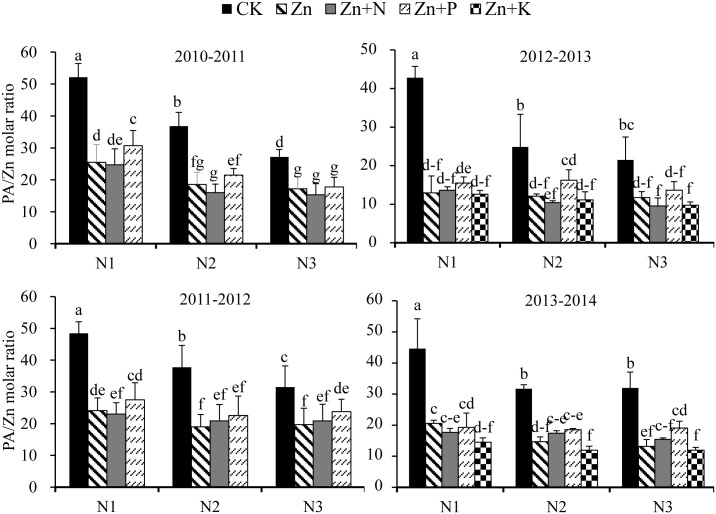
Grain PA/Zn molar ratio of winter wheat as influenced by soil N fertilizer rate (0 [N1], 120 [N2] or 240 [N3] kg N ha-1) and foliar fertilizer applications (distilled water spray [CK], ZnSO4·7H2O [Zn], ZnSO4·7H2O+urea [Zn+N], ZnSO4·7H2O+KH2PO4 [Zn+P], and ZnSO4·7H2O+ K2SO4 [Zn+K]) at Yangling. In 2010–2011 and 2011–2012, foliar Zn+K were not applied.Error bars represent standard error (n = 4). PA: phytic acid. Bars having different lowercase letters are significantly different (P < 0.05).